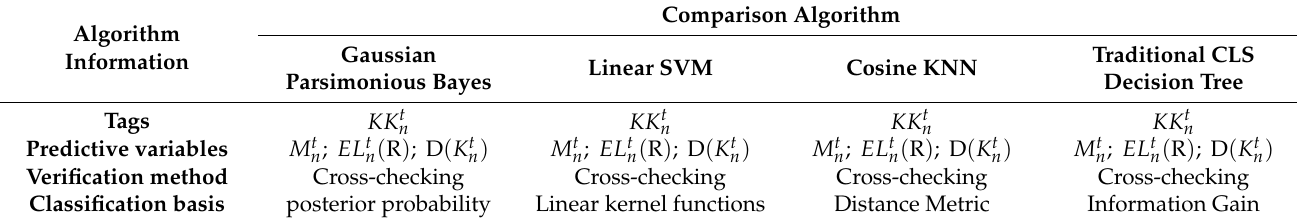
Table 12. Information on relevant comparison algorithms.